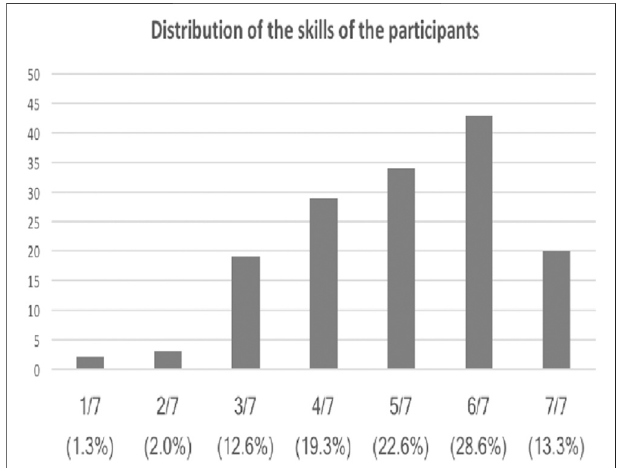
FIGURE3| Distributionoftheperceivedcomputerskillonascalefrom1 to 7 (in percentage).